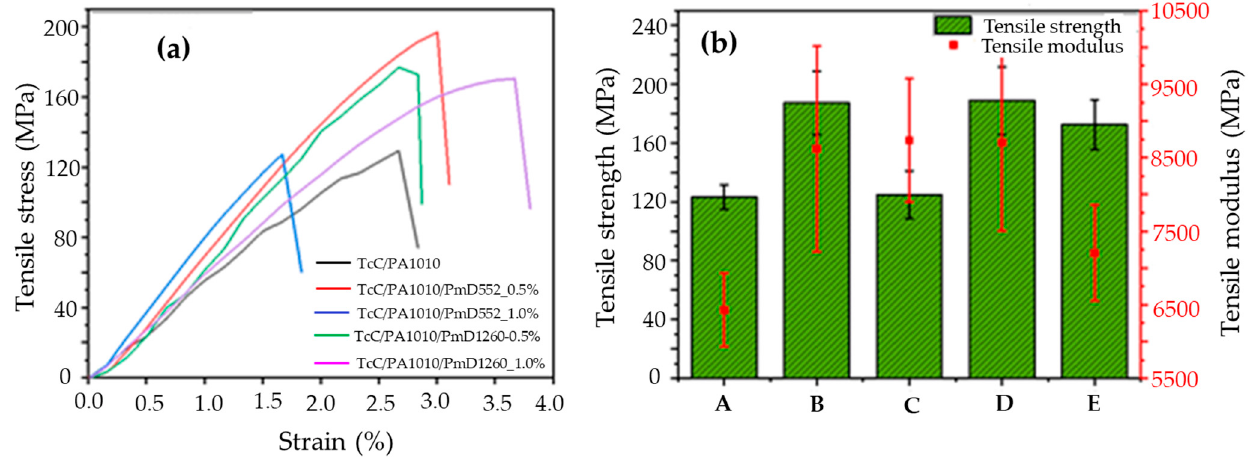
Figure 8. Tensile properties of thermally stabilised TcC/PA1010 filaments impregnated with Primids 552 and 1260: ( a ) stress–strain curves and ( b ) tensile strength and modulus. A—TcC/PA1010, B— TcC/PA1010/PmD552_0.5%, C—TcC/PA1010/PmD552_1.0%, D—TcC/PA1010/PmD1260_0.5% and E—TcC/PA1010/PmD 1260_1.0%.